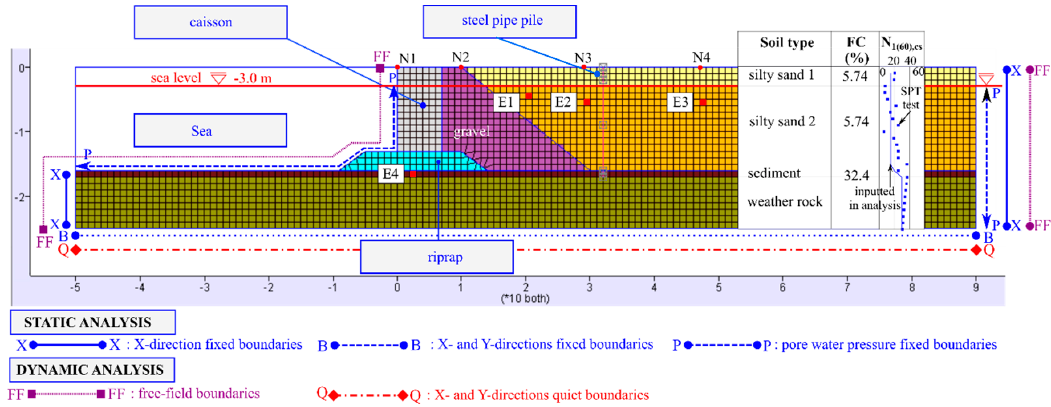
Figure 15. Youngil-man port cross section for FLAC modeling and analysis (dimension unit in meters).